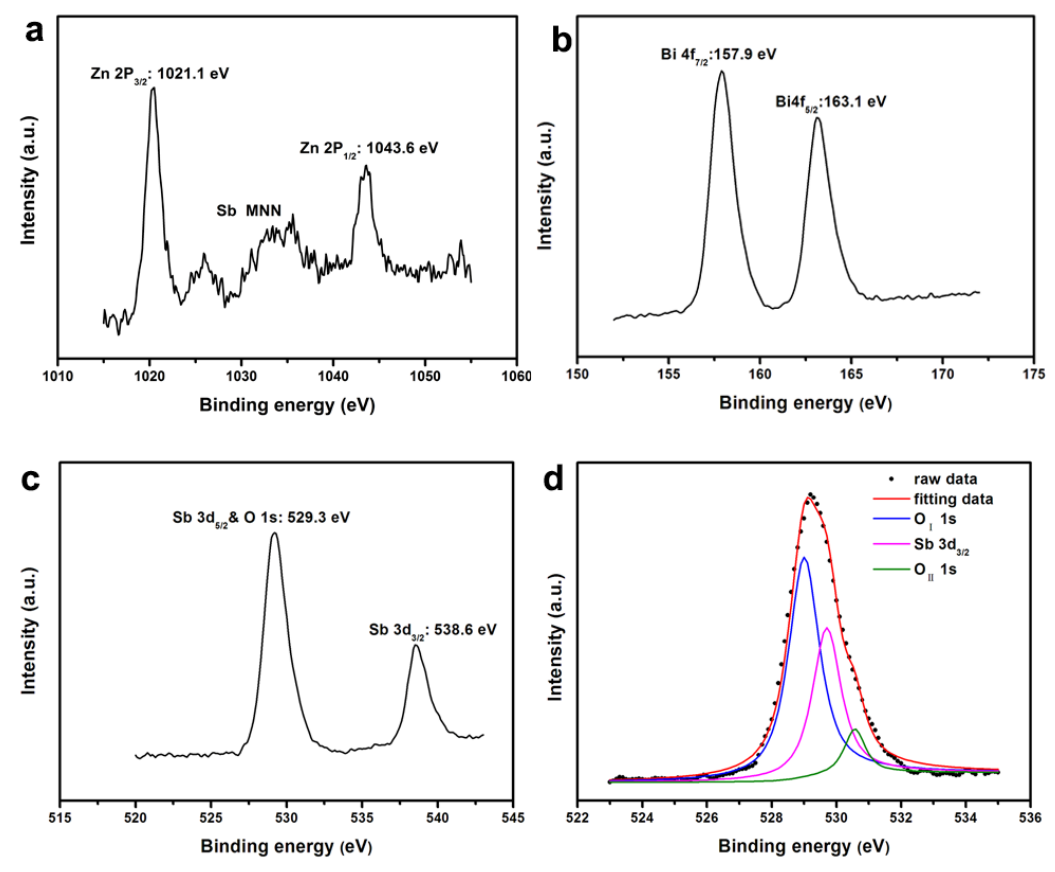
Figure 4. ( a ) The XPS spectrum of Zn 2p; ( b ) the XPS spectrum of Bi 4f; ( c ) the XPS spectrum of Sb 3d; and ( d ) peak curves of Sb 3d and O 1s for the XPS spectrum of 5/2 ZnBiSbO (O , lattice oxygen; O , chemisorbed oxygen). 4 I II